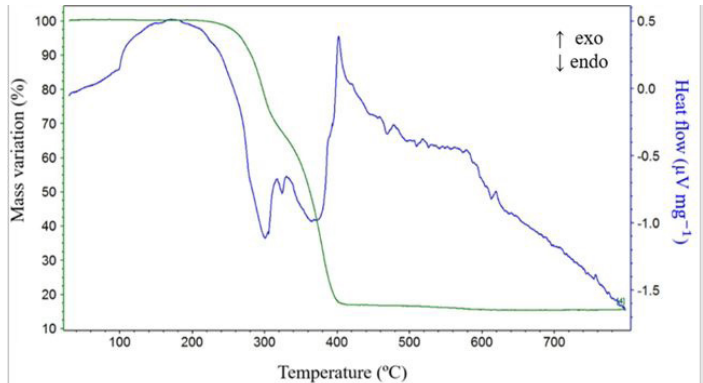
Figure 3. DSC/TG curves of the polyurethane used in the replica technique for ZnO